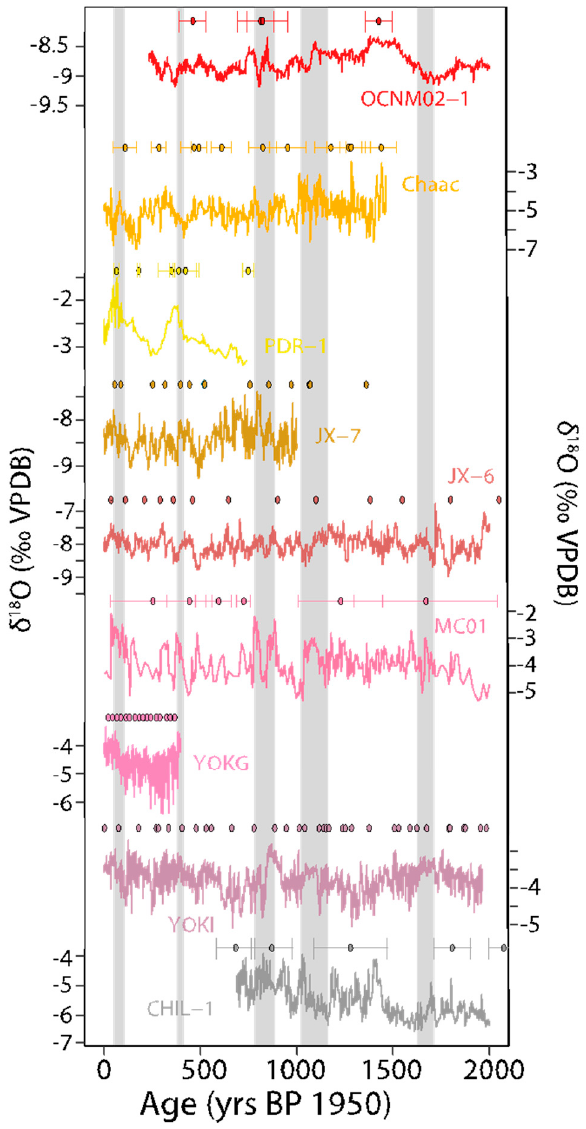
Figure 9. Speleothem records covering the last 2000 years at approximately decadal resolution or better that are included in SISAL_v1. See Table 1 for record details. Ages (solid circles) and associated uncertainties are shown with each record. Records are arranged by latitude.